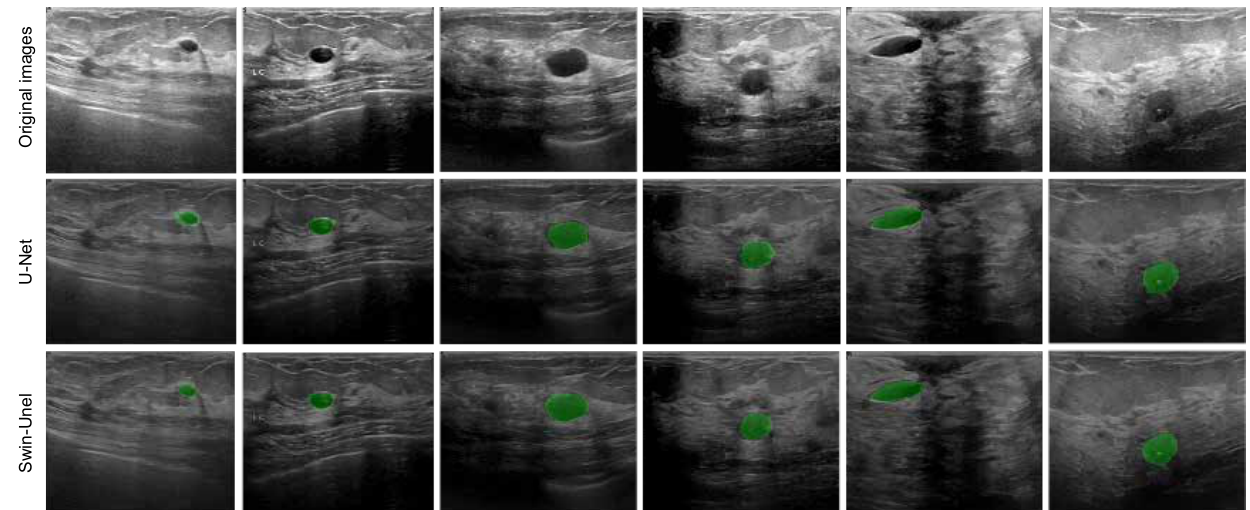
Figure 7 Examples of breast tumor segmentation using the U-Net and